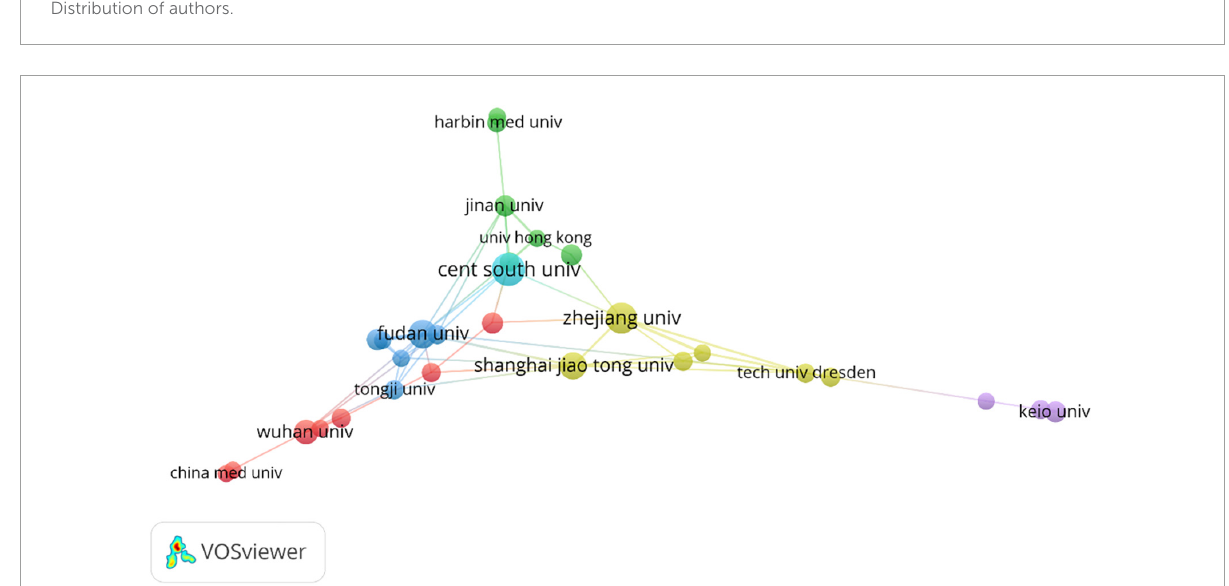
FIGURE2 Distribution of authors.